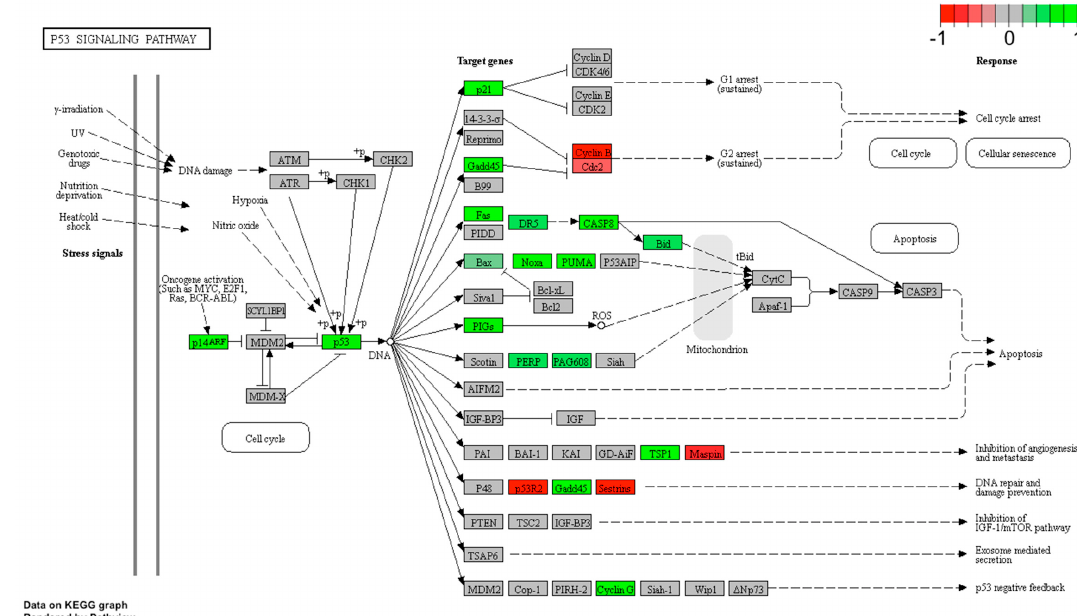
Figure 6. p53 signaling pathway in LNCaP cells treated with LEP (1 × 10 − ⁶ M). Expression changes of target genes are mapped by colours; green colour—statistically significant increase in expression, red colour—statistically significant decrease in expression, grey colour—statistically insignificant.